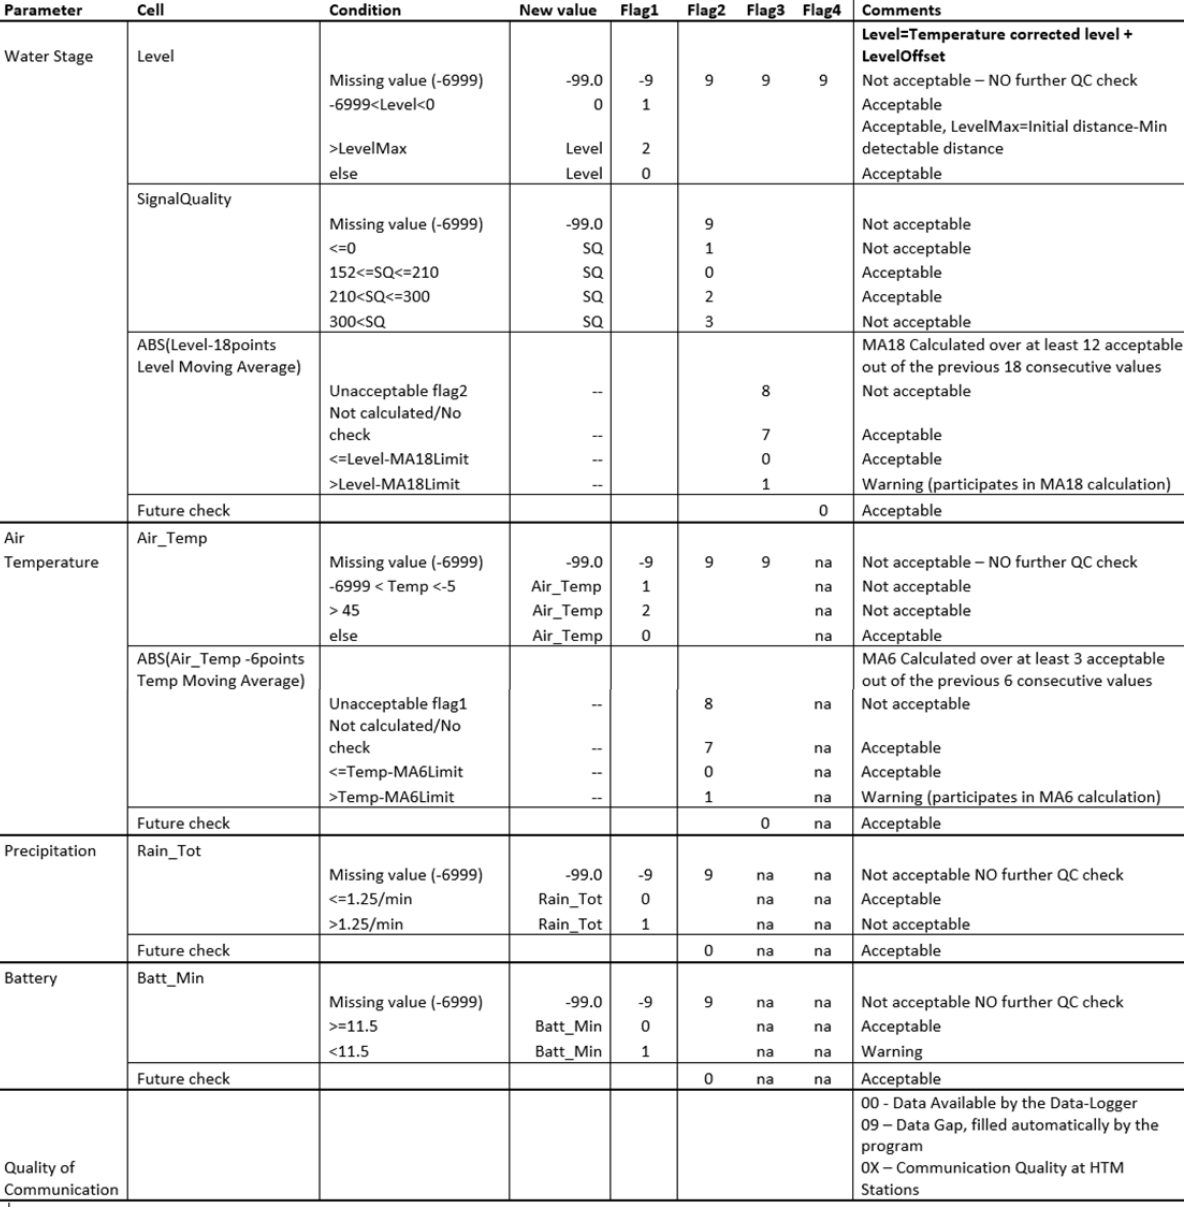
Figure A2. Quality tests applied on the data recorded by NOA’s automatic stations.